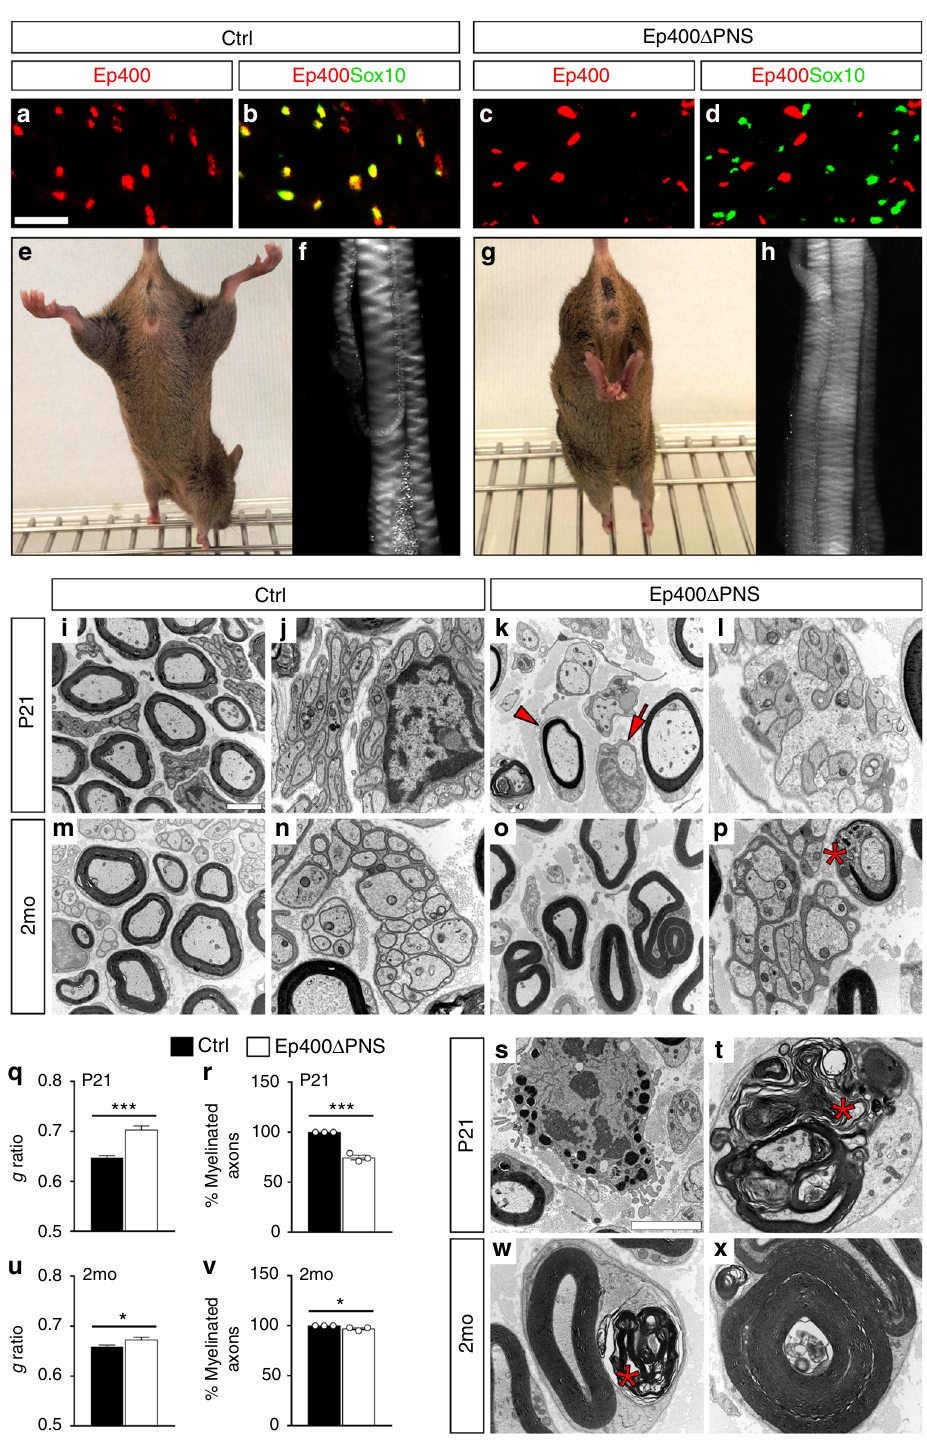
Fig. 1 Peripheral neuropathy resulting from Ep400 deletion in Schwann cells (SCs). a – d Occurrence of Ep400 in SCs of sciatic nerves from control ( a, b ) and Ep400 Δ PNS ( c , d ) mice at P21 as determined by co-immuno fl uorescence studies with antibodies against Ep400 (red) and Sox10 (green) to prove ef fi cient SC-speci fi c deletion. Sox10-negative cells in the nerve retained Ep400 and may represent endoneurial fi broblasts, pericytes, endothelial cells, or immune cells. Scale bar: 25 µ m. e – h Hindlimb clasping phenotype ( e , g ) and sciatic nerve hypomyelination ( f , h ) in Ep400 Δ PNS ( g , h ) as compared to control ( e , f ) mice at P21. i – p , s , t , w , x Representative electron microscopic pictures of sciatic nerve sections from control ( i , j , m , n ) and Ep400 Δ PNS ( k , l , o , p , s , t , w , x ) mice at P21 ( i – l , s , t ) and 2 months (2 mo) ( m – p , w , x ) in overview ( i – p ) and at higher resolution ( s , t , w , x ). Magni fi cations depict an activated macrophage ( s ) and various myelin abnormalities ( t , w , x ). Arrow, unmyelinated axon; arrowhead, hypomyelinated axon; asterisk, myelin debris. Scale bars: 2.5 µ m. q , r , u , v Determination of the mean g ratio ( q , u ) and the number of myelinated axons as percentage of total axons with a diameter ≥ 1 µ m ( r , v ) in ultrathin sciatic nerve sections of control (black bars) and Ep400 Δ PNS (white bars) mice at P21 ( q , r ) and 2 mo ( u , v ). All large caliber axons were myelinated in control mice. Statistical signi fi cance was determined by unpaired, two-tailed Student ’ s t test (* P ≤ 0.05; *** P ≤ 0.001). Exact values are listed in Supplementary Tables 1 and 2 and source data are provided as a Source Data fi